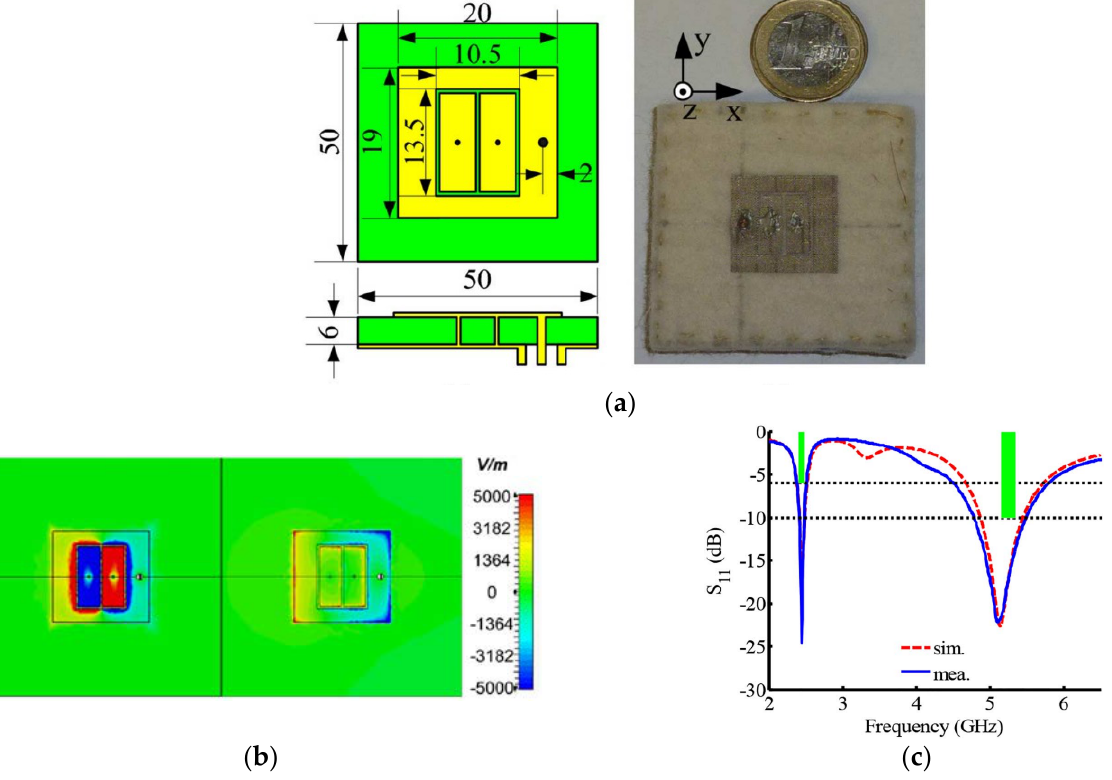
Figure 4. A compact all-textile dual-band antenna loaded with metamaterial-inspired structure [57]. ( a ) The simulation model and the prototype (in mm). ( b ) The E-field distribution at 2.45 GHz ( − 1 mode) and 5.2 GHz (+1 mode) in z-direction. ( c ) S11 curves of the wearable antenna in simulation and measurement.